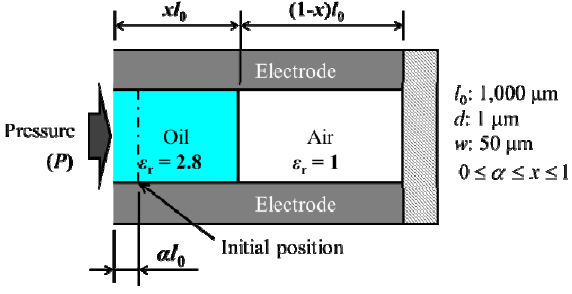
Figure 2. Simplified model of tactile sensor.